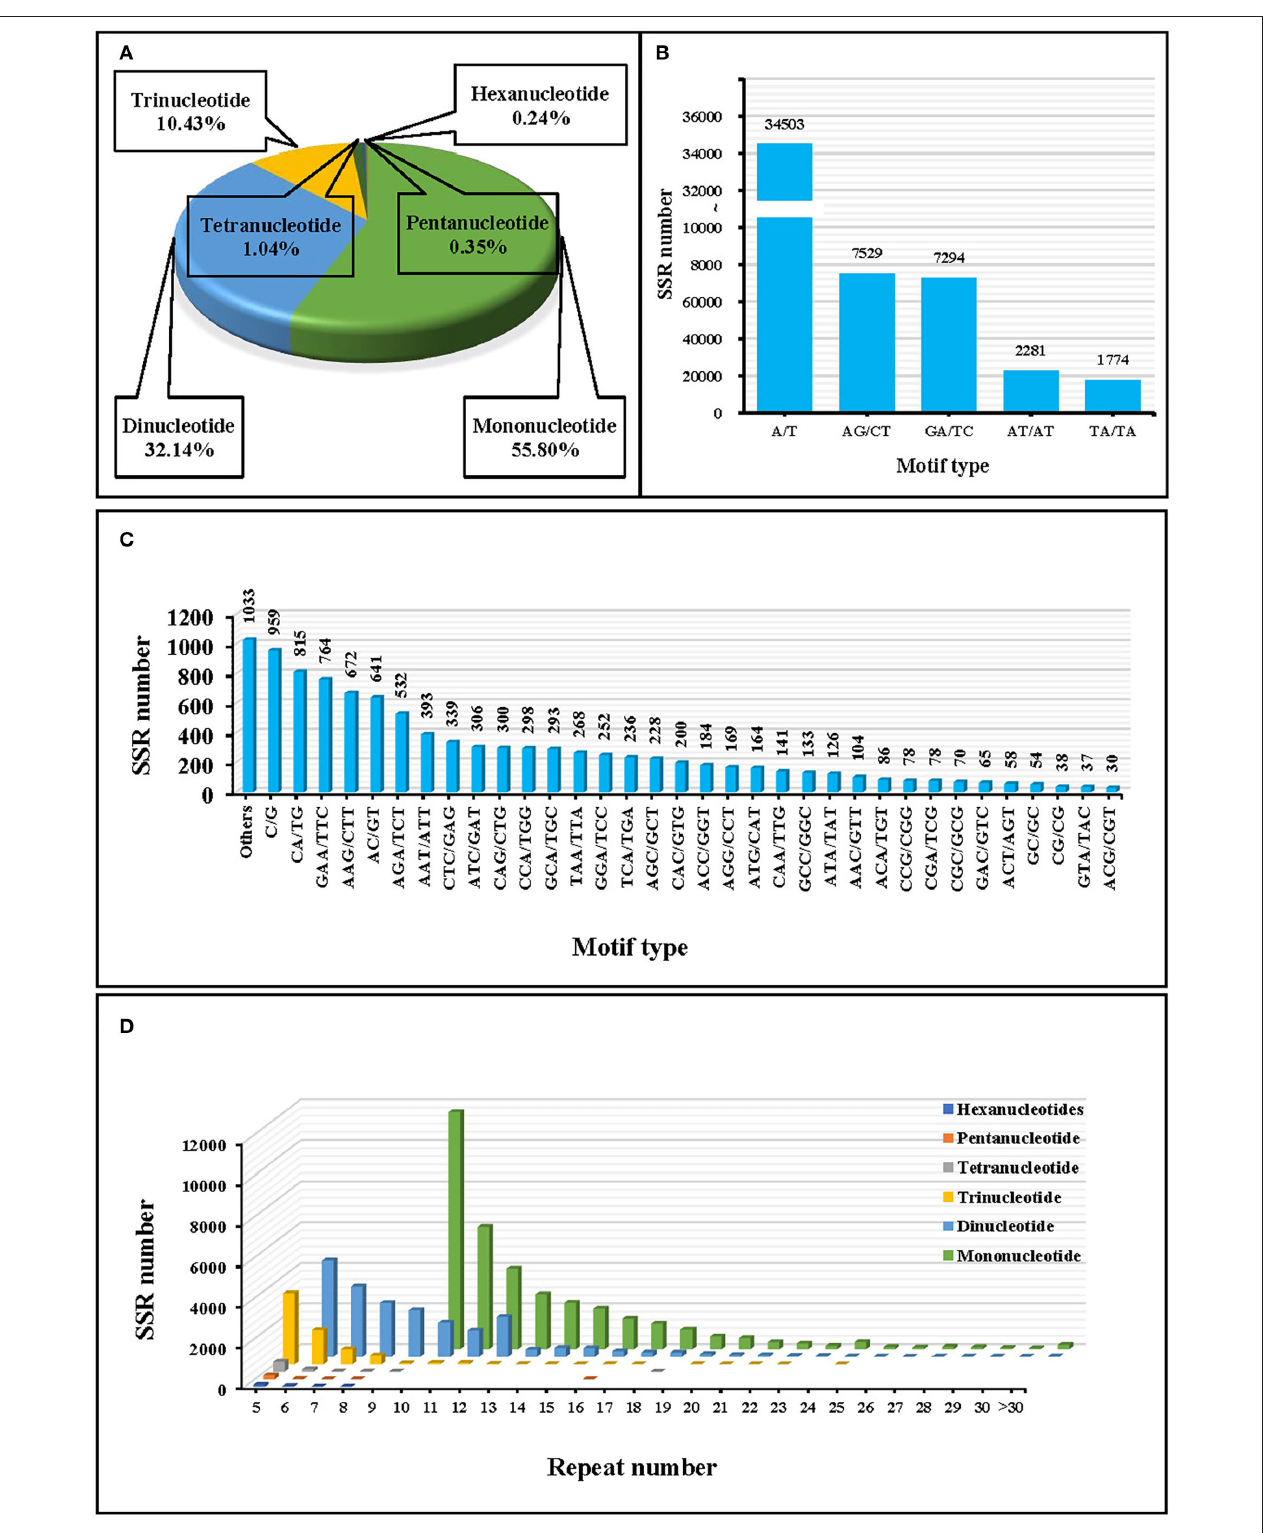
FIGURE 2 | Statistics of simple sequence repeats (SSRs) in J. mandshurica . (A) Statistics of the proportion of different motif types. (B,C) Statistics of the SSR numbers of different motif types. (D) Statistics of the number of repeat types for different motifs.